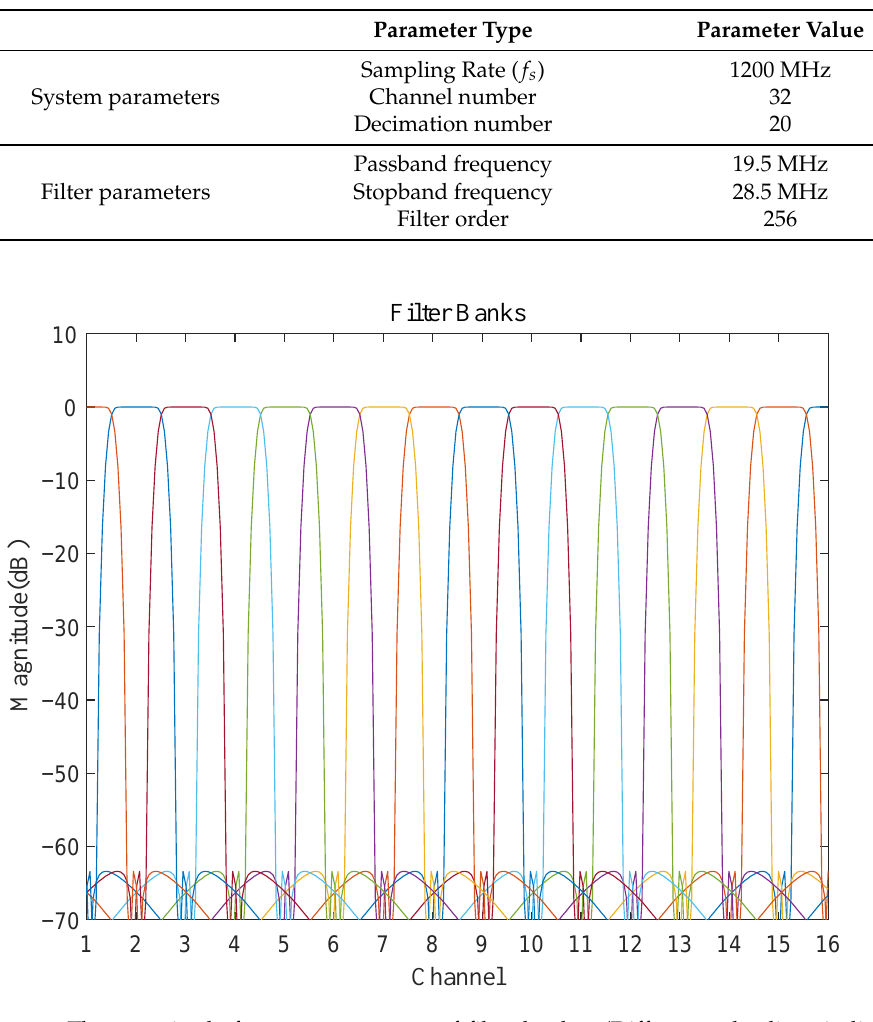
Figure 7. The magnitude frequency response of filter banks. (Different color lines indicate the frequency response of the bandpass filter for different